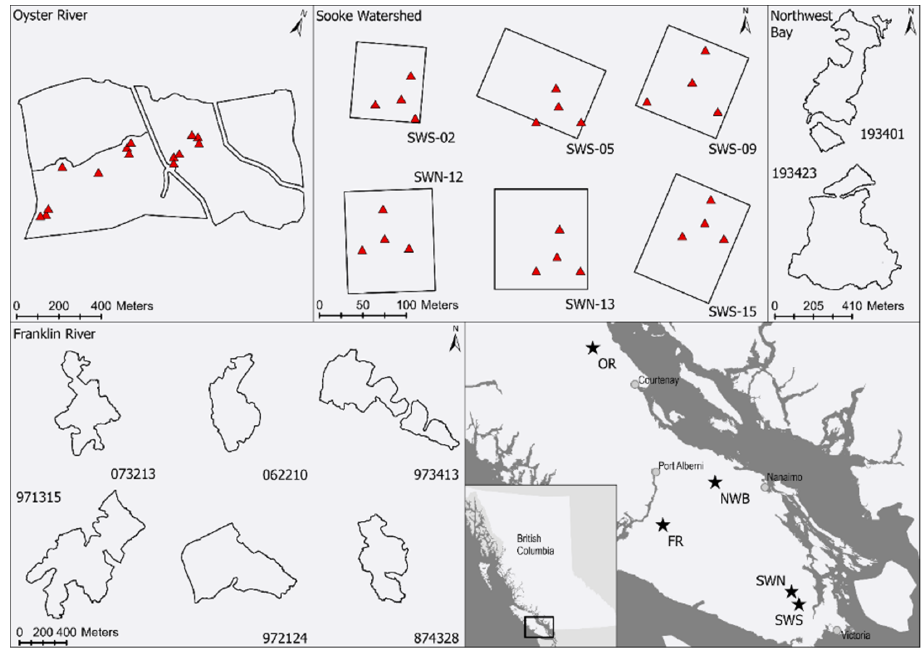
Figure 1. Study site map showing layouts of block boundaries (black lines) and sample plot locations (red triangles) at Oyster River (OR), Sooke Watershed South (SWS) and Sooke Watershed North (SWN), Northwest Bay (NWB), and Franklin River (FR). All sites are located in Douglas-fir dominated sites on Vancouver Island, with central site locations shown (stars) in the lower right panel.